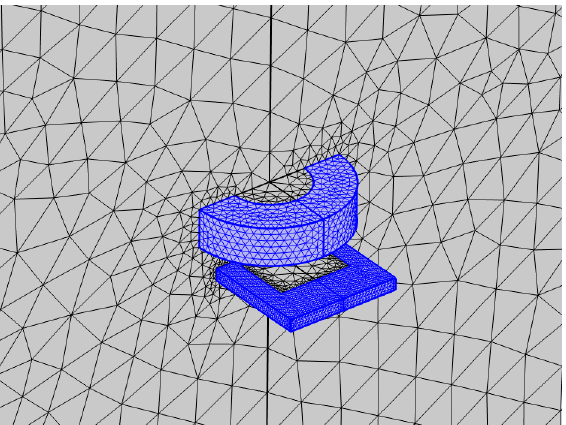
Figure 19. Distribution of the FEM mesh near the plate and the coil, whose elements are depicted in blue (coarsest case: 69,702 tets for plate and 1,171,167 tets for air): element size within the plate has to be smaller than skin depth; many elements have to be used in the air region to ensure a good